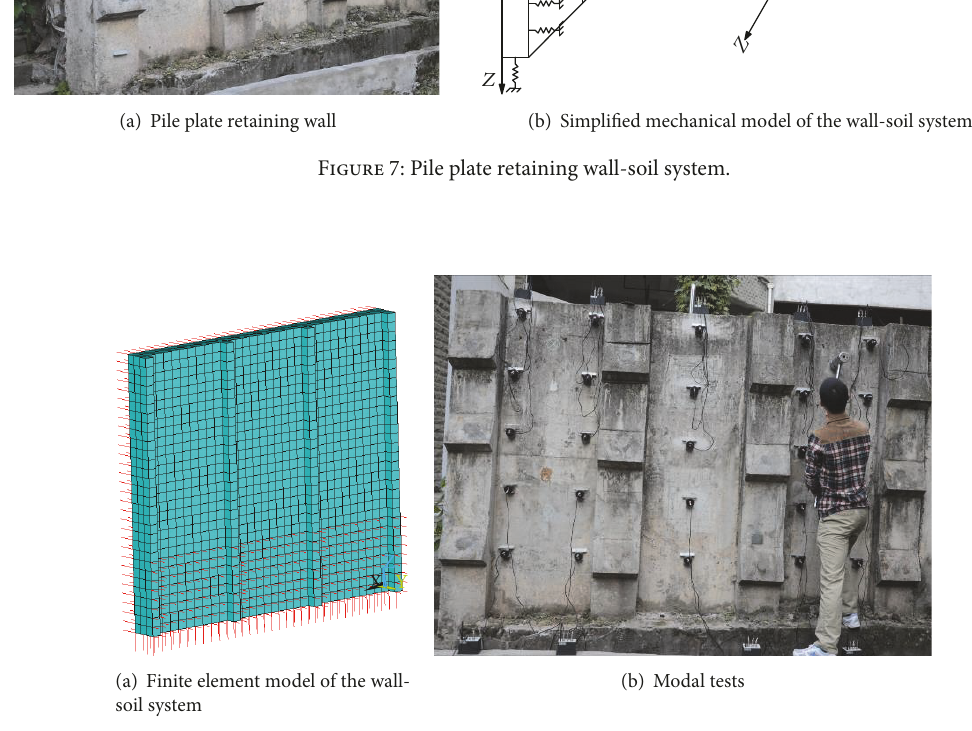
Figure 8: Baseline finite element model of the pile plate retaining wall-soil coupling